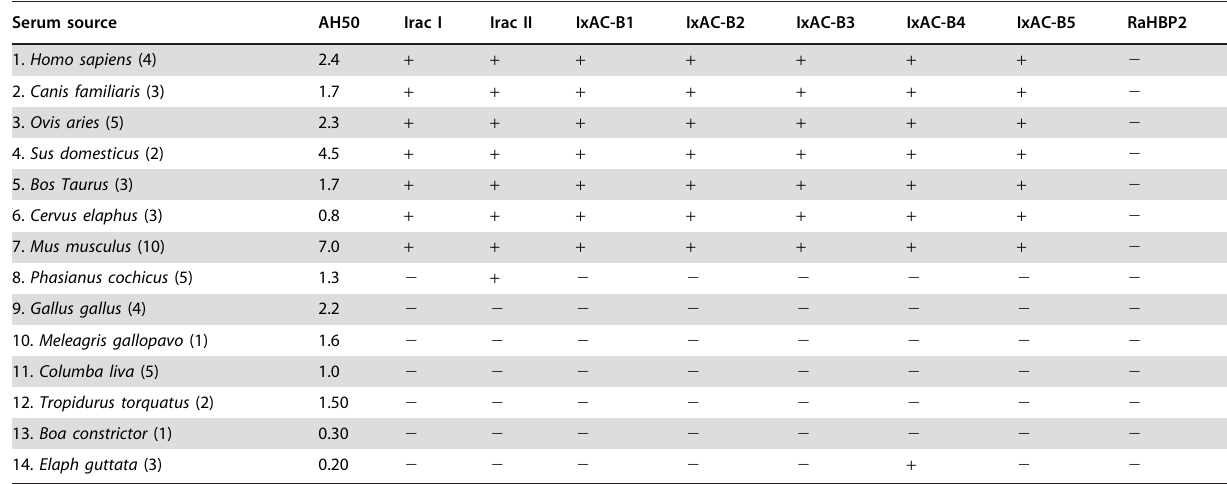
Figure 9. Effect of IxAC proteins on the deposition of C3b and factor B on agarose-coated plates. Loading human serum on agarose-coated microplate wells activates the alternative complement pathway. Purified recombinant IRAC II (A–B) or IxAC-B1 (C–D) were added after 30, 45 or 60 minutes. The reactions were stopped at various times. C3b and factor B deposition was detected using anti-C3 antibody (A–C) or anti-factor B antibody (B–D), respectively. Black diamond: no added protein; black square: 30 min.; black triangle: 45 min.; cross: 60 min.